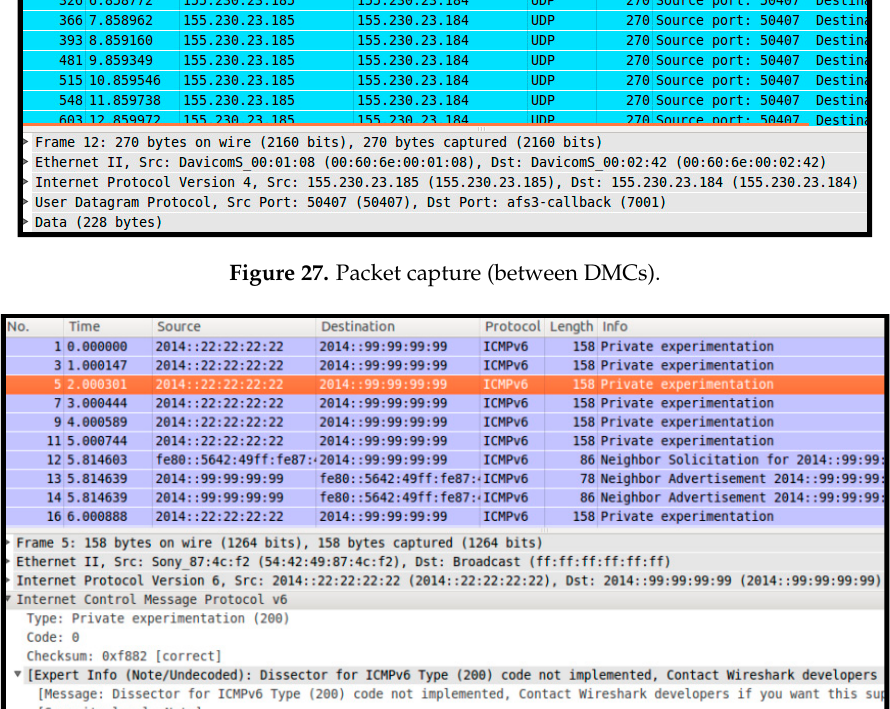
Figure 28. Packet capture (at the R ‐ GW of domain 2).